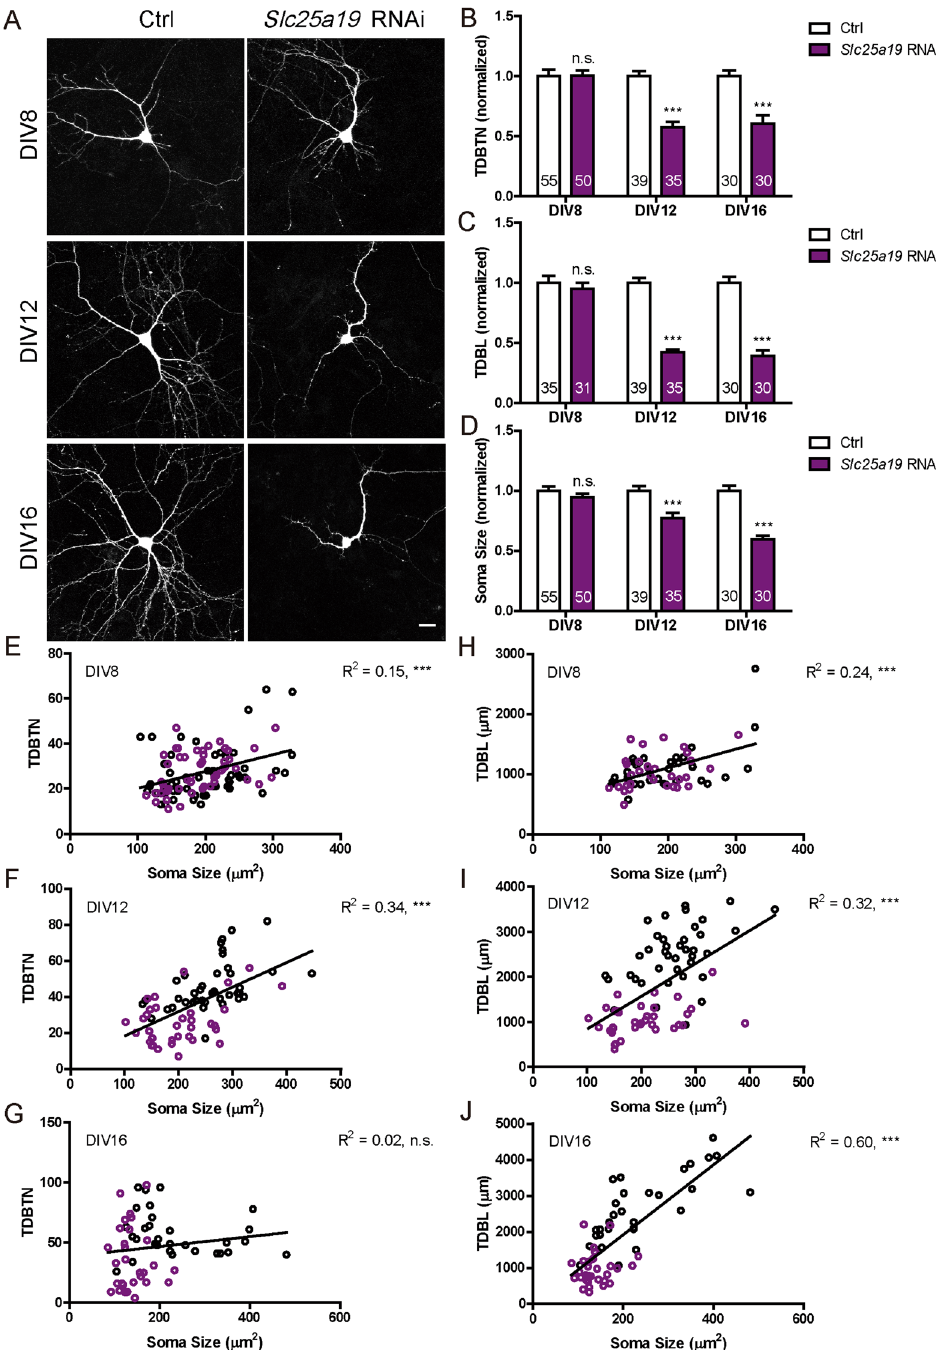
Figure 3. Slc25a19 knockdown in primary hippocampal neurons significantly reduced TDBTN, TDBL and soma size. ( A ) Representative images of primary hippocampal neurons transfected with control and Slc25a19 RNAi plasmids, fixed at DIV8, DIV12 or DIV16. Scale bar: 20 μ m. ( B ) Quantitation of TDBTN: Slc25a19 RNAi at DIV8 (1.00 ± 0.04, n.s.), DIV12 (0.57 ± 0.05, P < 0. 001), DIV16 (0.61 ± 0.07, P < 0. 001). ( C ) Quantitation of TDBL: Slc25a19 RNAi at DIV8 (0.95 ± 0.05, n.s.), DIV12 (0.42 ± 0.02, P < 0. 001), DIV16 (0.39 ± 0.05, P < 0. 001). ( D ) Quantitation of soma size: Slc25a19 RNAi at DIV8 (0.95 ± 0.03, n.s.), DIV12 (0.77 ± 0.04, P < 0. 001), DIV16 (0.59 ± 0.03, P < 0. 001). ( B – D ) Two way ANOVA followed by Bonferroni’s post-test. Data for control neurons same as that shown in Fig. 1. ( E – G ) Significant correlations exist between TDBTN and soma size at DIV8 ( E , n = 105, R 2 = 0.15, P < 0. 001), DIV12 ( F , n = 74, R 2 = 0.34, P < 0. 001) but not DIV16 ( G , n = 60, R 2 = 0.02, n.s.). ( H – J ) Significant correlations are observed between TDBL and soma size at DIV8 ( H , n = 66, R 2 = 0.24, P < 0. 001), DIV12 ( I , n = 74, R 2 = 0.32, P < 0. 001) and DIV16 ( J , n = 60, R 2 = 0.60, P < 0. 001). In ( E – J ) Black circles represent control neurons, while purple circles represent Slc25a19 RNAi